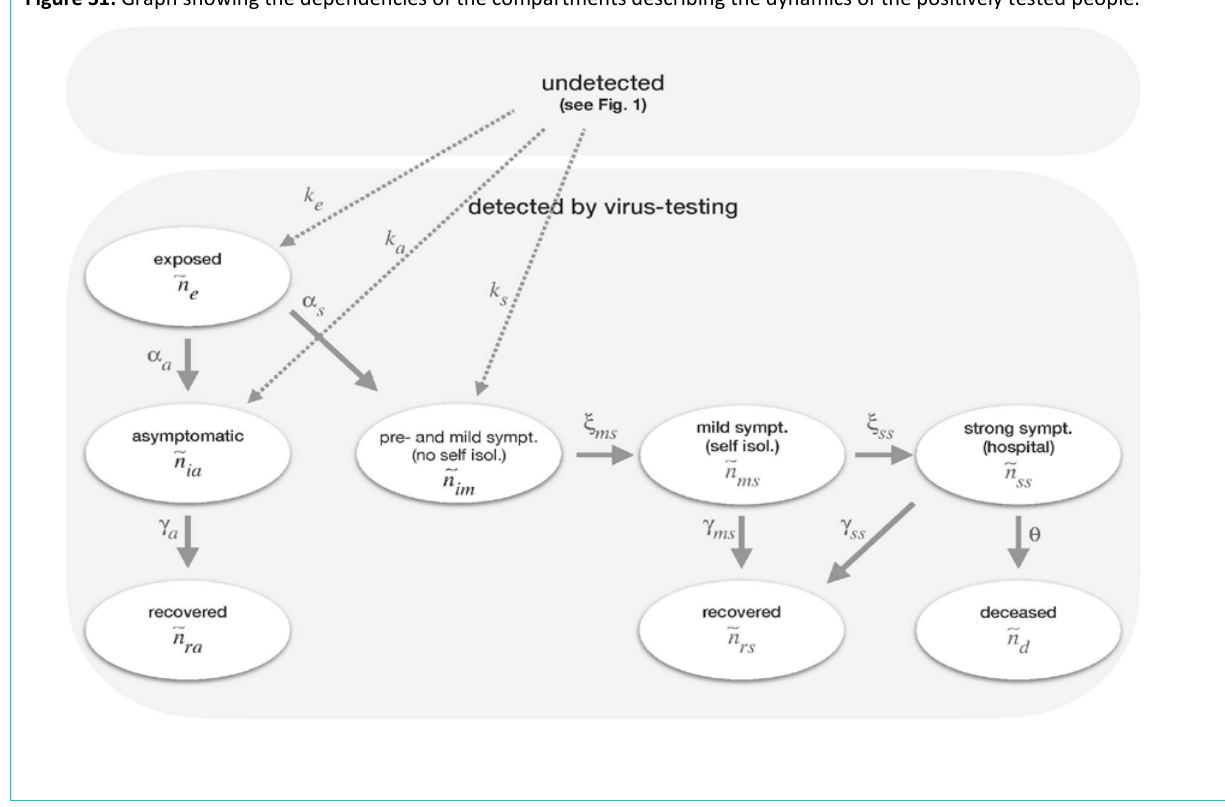
Figure S1: Graph showing the dependencies of the compartments describing the dynamics of the positively tested